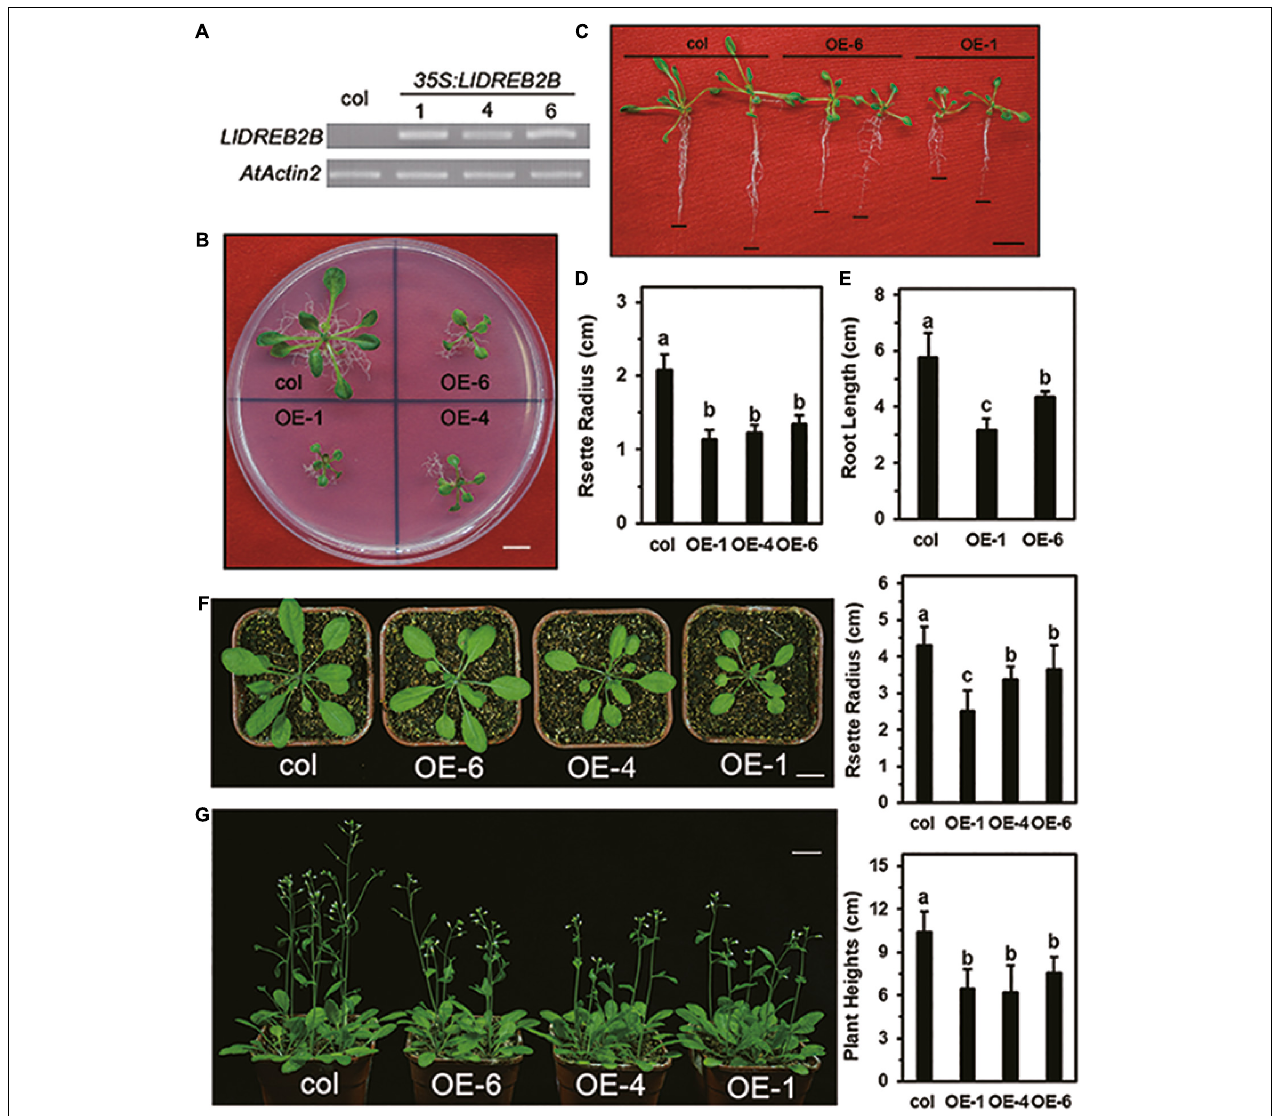
FIGURE 8 | Growth of transgenic Arabidopsis plants expressing wild-type LlDREB2B under control of the 35S promoter. (A) RT-PCR analysis of transgenic Arabidopsis lines. AtActin2 was used as a control. (B) Seedlings of wild-type and transgenic lines grown on MS medium for 3 weeks. (C) Seedlings were grown for 7 days under normal conditions and then grown on vertically oriented MS medium for an additional 9 days. Black lines indicate root tips; Bar = 1 cm. Ten plants of each line were tested; one representative picture is shown. (D) Rosette radii of the plants shown in B were counted. (E) Root growth of the plants shown in D were counted. Bars are means ± SD of the tested plants. Different letters indicate significant differences among these lines (Student–Newman–Keuls test, P < 0.05). (F) The 2-week-old seedlings were transferred from agar plates to soil for 14 days. Bar = 1 cm. Plant rosette radii are shown to the right. Ten plants of each line were tested; one representative picture is shown. Bars are means ± SD of the tested plants. Different letters indicate significant differences among these lines (Student–Newman–Keuls test, P < 0.05). (G) The 2-week-old seedlings were transferred from agar plates to soil for 21 days. Bar = 1 cm. Plant heights are shown to the right. Eighteen plants of each line were tested; one representative picture is shown. Bars are means ± SD of the tested plants. Different letters indicate significant differences among these lines (Student–Newman–Keuls test, P <